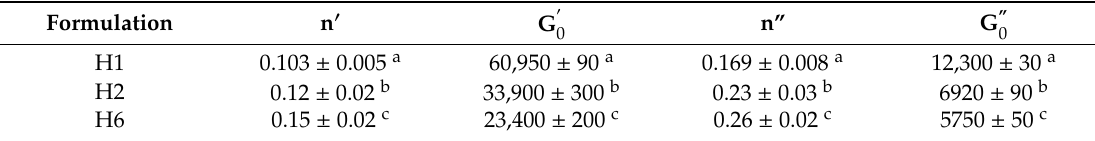
Table 2. Fit parameters obtained by applying Equations (4) and (5) on the curves presented in Figure 4. Parameters were fitted using three